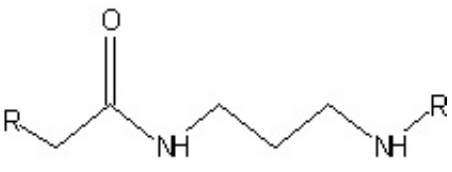
Figure 5. Chemical structure of a